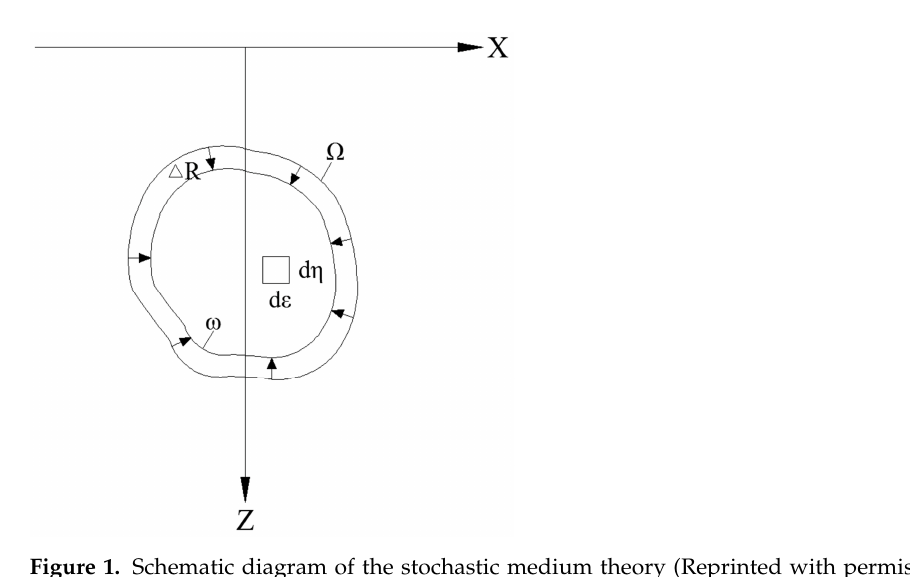
Figure 1. Schematic diagram of the stochastic medium theory (Reprinted with permission from Ref. [32]. Copyright 2021 Springer Nature.).